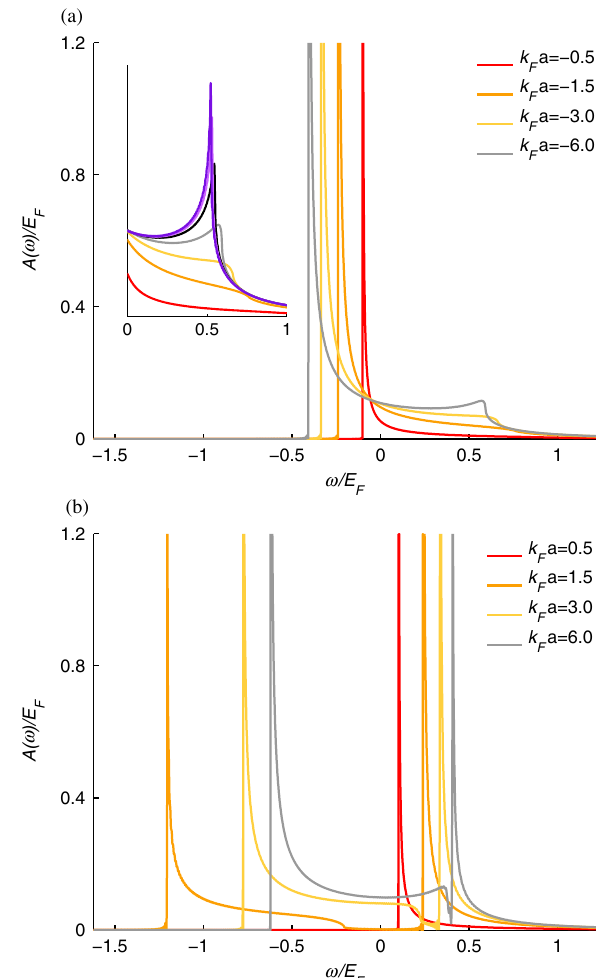
FIG. 2. RF-absorption spectra for different values of scattering length a . (a) When a < 0 , no bound state is present and the ¼ (cid:3) E spectrum exhibits one power-law edge singularity at @ ! 0 due to the processes illustrated in Fig. 3(b). In addition, a weak ¼ (cid:3) E þ E F is found, attributed to the nonanalyticity at @ ! 1 excitations from the bottom of the band, illustrated in Fig. 3(c). This nonanalyticity is magnified and plotted for additional large values of k F a ¼ (cid:2) 12 ; (cid:2) 18 ; (cid:2) 24 in the inset in (a). At unitarity, the nonanalyticity transforms into a true divergence with expo- nent 1 = 4 , which is described by a universal result shown in Eq. (18). (b) When a > 0 , the impurity creates a bound state. The spectra in this case exhibit two threshold singularities, which are offset by an energy j E F (cid:2) E b j , as well as an additional cusplike singularity, the origin of which is illustrated in Fig.